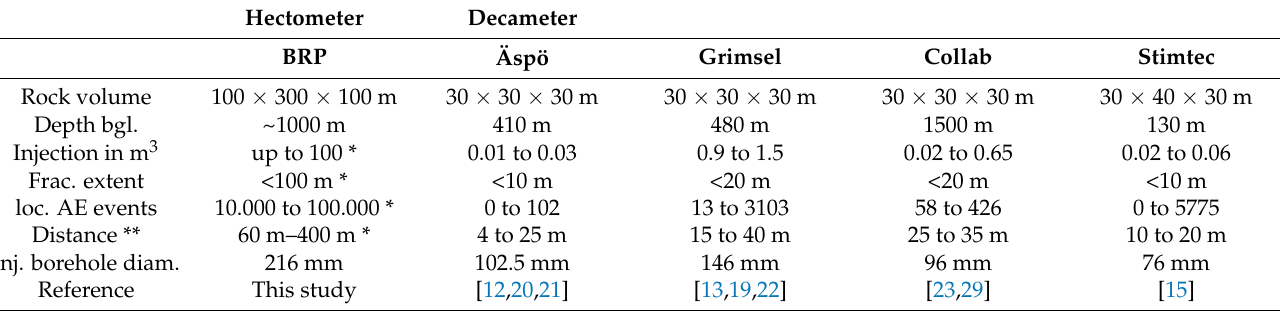
Table 2. Comparison of decameter scale and hectometer scale injection experiments. Due to the depth and distance to the nearest opening (tunnel), the BRP experiment is expected to represent more realistic stress conditions, pore pressure flow, and seismic response than the decameter-scale experiments. A detailed discussion is provided in the